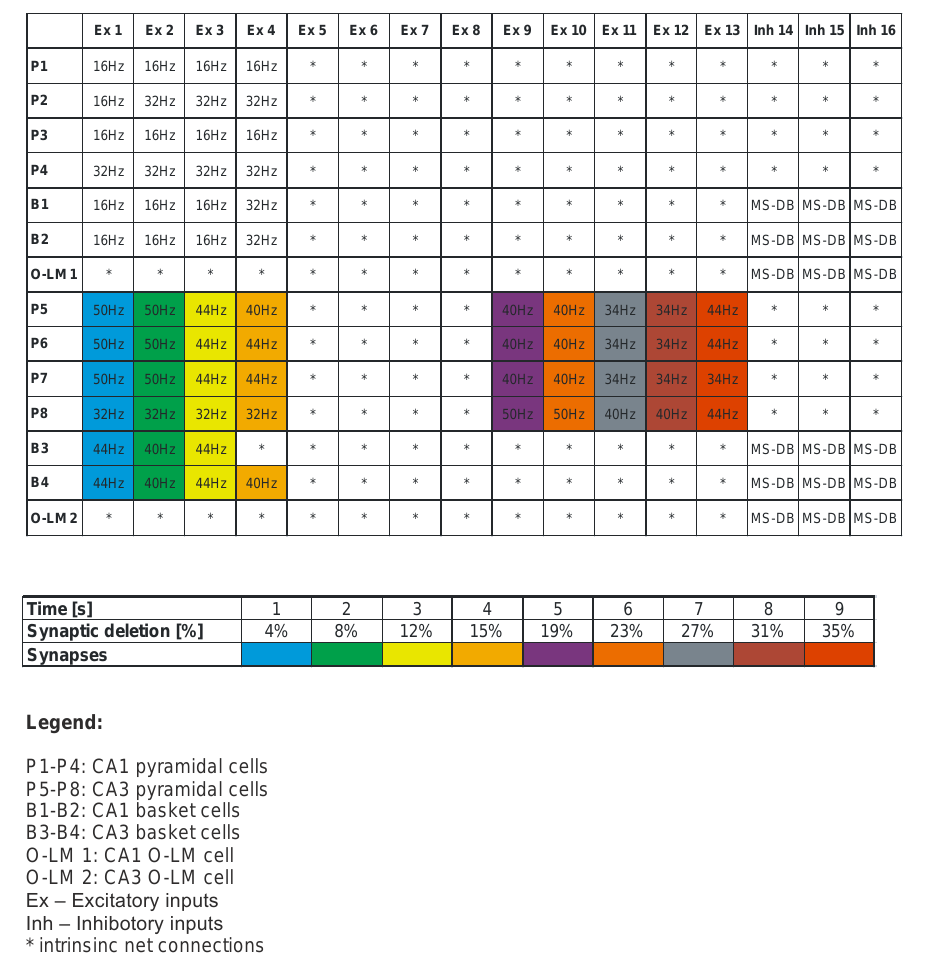
Figure 2. On Pyramidal cells from CA3 and CA1 regions we have together 8*13 = 104 (100%) excitatory synapses. Color marker the deleted synapses during simulation. The deletions were made only in CA3 microcircuit. 2.1. CA3 Cells Every CA3 pyramidal cell, CA3 basket cell and CA3 O-LM cell are constructed with compartments and every dendrite has a synapse, which is either excitatory or inhibitory. Excitatory inputs in stratum lucid dendrites are received from CA3 pyramidal cells, EC2 and dentate gyrus (DG). Excitatory connections are received by their distal dendrites from EC2 and by medium dendrites from DG granule cells’ mossy fibers. Inhibitory impulses come from connections in the medial septum of their somas. Each O-LM cell receives excitatory and inhibitory connections. The first ones are received from active CA3 pyramidal cells in their basal dendrites, and the second ones